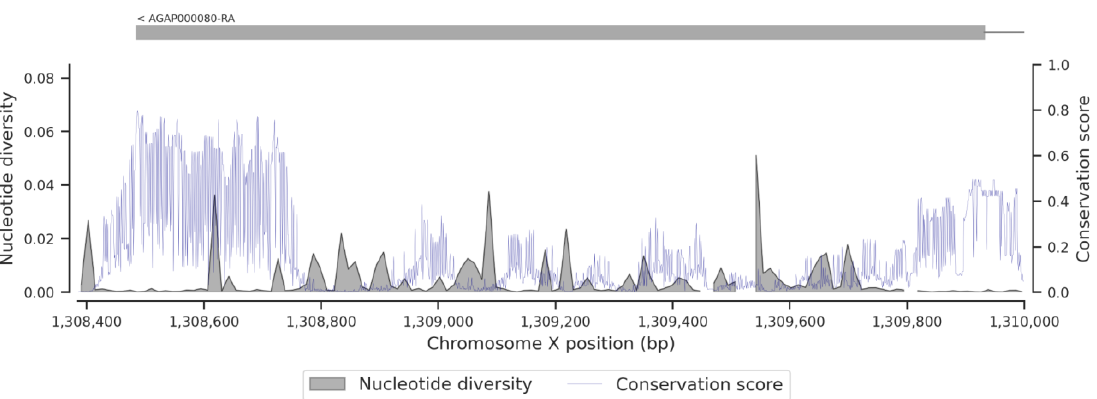
Figure A6. Conservation score and nucleotide diversity in a window of 12 bp within the BTB and connector region of the Fruitless gene; upper figure shows the BTB and connector region (rectangles correspond to the exonic regions, and the simple lines are the intronic regions); lower figure shows the conservation score (blue line) and the nucleotide diversity (dark fill) plot.